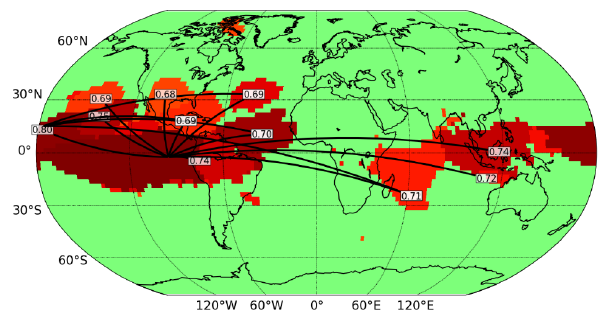
Figure 5. Climate network visualisation of regional node clusters (reprinted from Hlinka et al.,